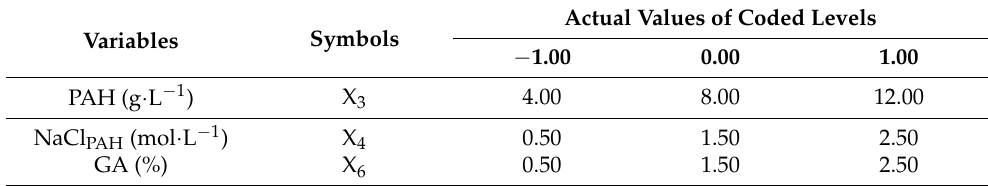
Table 2. Independent variables and their coded levels for RSM